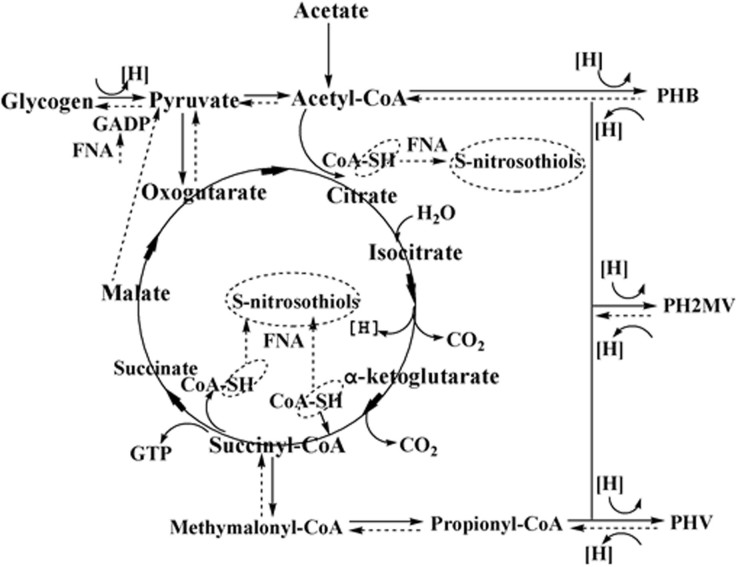
FNA inhibitory mechanisms on PAOs (dark solid line: anaerobic inhibitory mechanisms adapted from the literature6; dark dash line: oxic inhibitory mechanisms adapted from the literatures45).